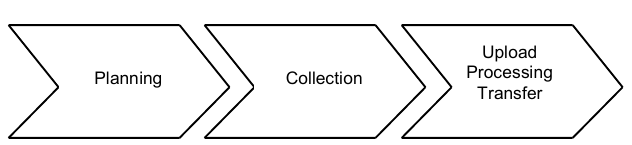
Modular Structure of MRS Value